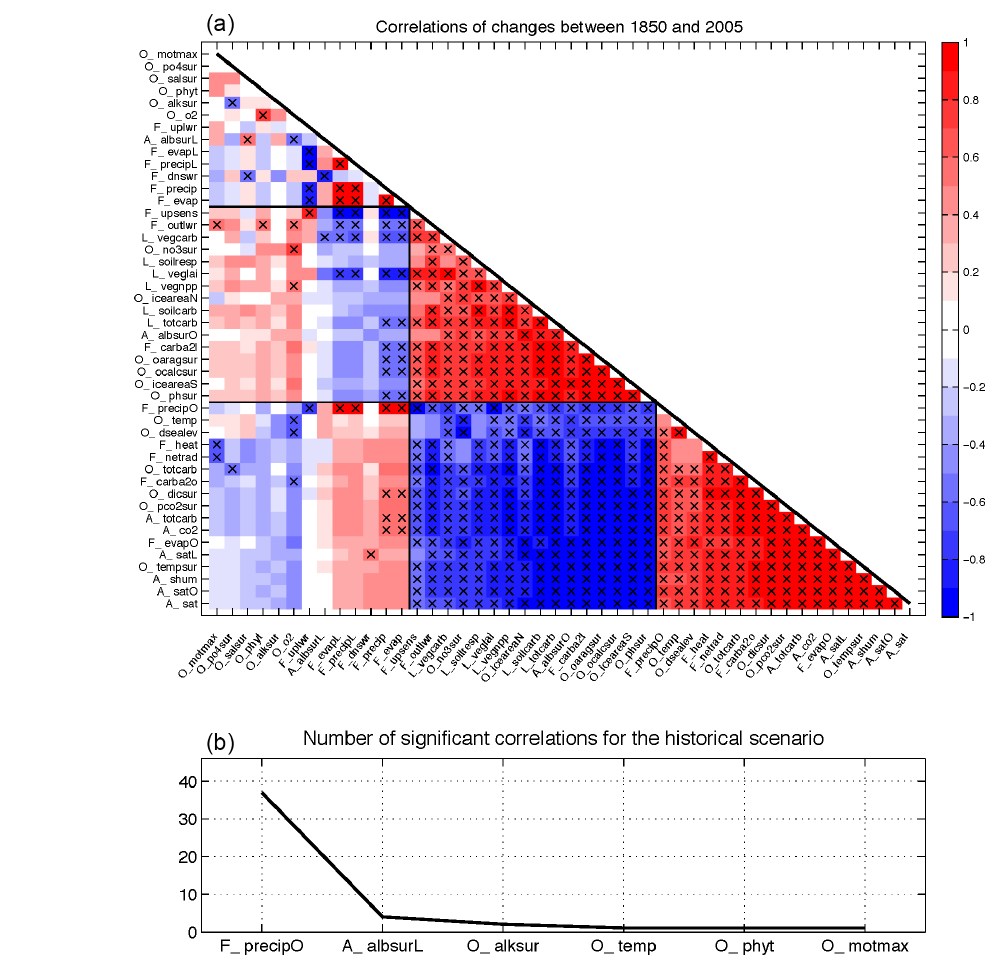
Figure 3. (a) Correlation matrix for the historical scenario. The correlations are calculated between changes in the 46 model output vari- ables for temporal differences between 1850–1860 and 1995–2005 from the results of the perturbed parameter simulations (as in Fig. 1). Correlations significant at a 5% significance level are marked with crosses. The order of the variables was determined based on their cor- relation strength to “surface air temperature” (A_sat) in the historical scenario. Prefixes A, O, L, and F stand for atmosphere, ocean, land, and fluxes, respectively; for a detailed description of the model output variables, see Table A1. (b) Indicators as identified from the SCo- MaE analysis of the correlation matrix above as illustrated in Fig. 2, ranked by the amount of significant correlations. The indicators are as follows: “precipitation over ocean” (F_precipO), “land surface albedo” (A_albsurL), “ocean surface alkalinity” (O_alksur), “mean ocean temperature” (O_temp), “ocean phytoplankton” (O_phyt), and “ocean overturning”